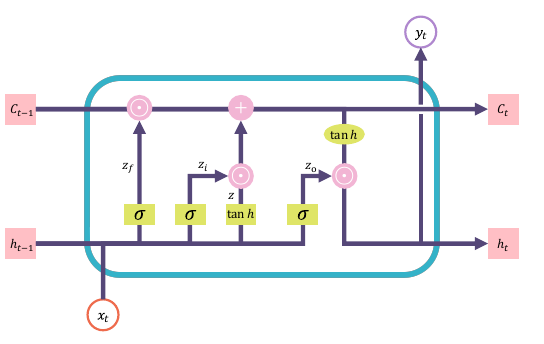
Figure 4. DCNN-DBN module structure diagram.